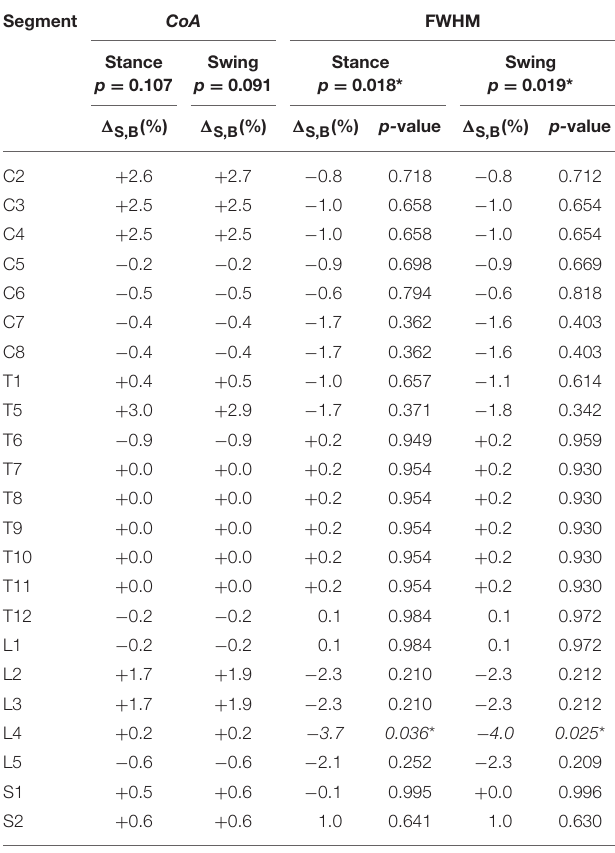
TABLE 1 | Differences between shod and barefoot running in the center of activity ( CoA ) and full width at half maximum (FWHM) of the electromyographic activities mapped onto the estimated rostrocaudal location of the spinal cord (segments C2 to